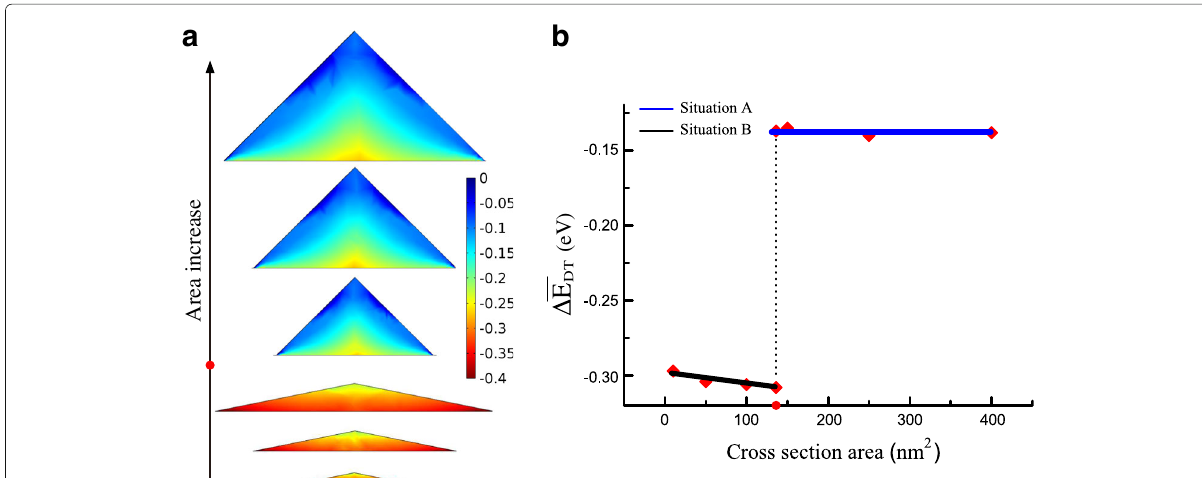
Fig. 4 a The distribution of (cid:3) E DT with increase of the area (the colorbar denotes the value of (cid:3) E DT ). b The average of (cid:3) E DT vs. the area. The critical value is marked in reddot in the area